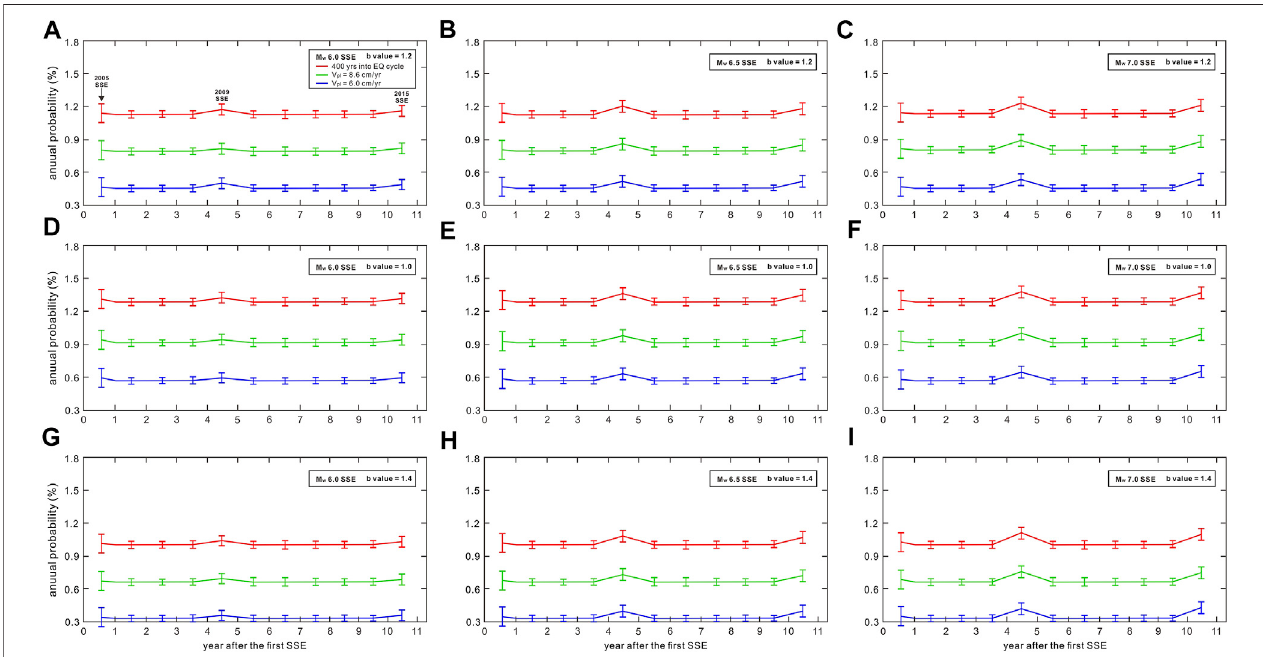
FIGURE7| AnnualprobabilityofanM w ≥ 7.5earthquakewithamaximumofM w 8.7ontheRyukyufaultfollowingthe2005,2009,and2015SSEs.Theblue,green, and red curves represent the scenario of V pl = 6.0 cm/yr, 8.6 cm/yr, and 400 years into the earthquake cycle, respectively. The vertical bars are the uncertainty of probability. (A – C) Probabilities under the frame of the observed b value of 1.2 in the earthquake cycles. (D – F) Same as (A – C) but for a b value of 1.0 and (G – I) for a b value of